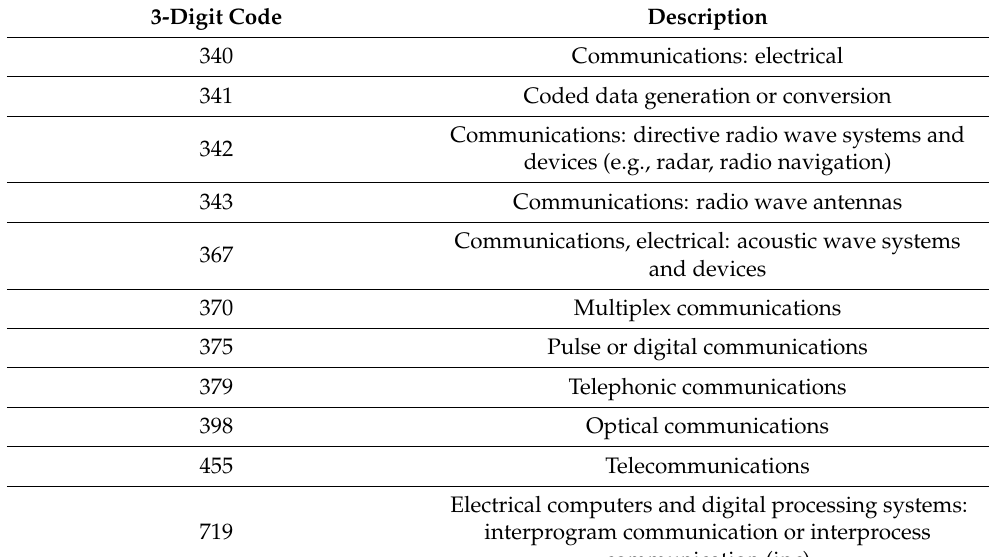
Table 1. Technology classes in